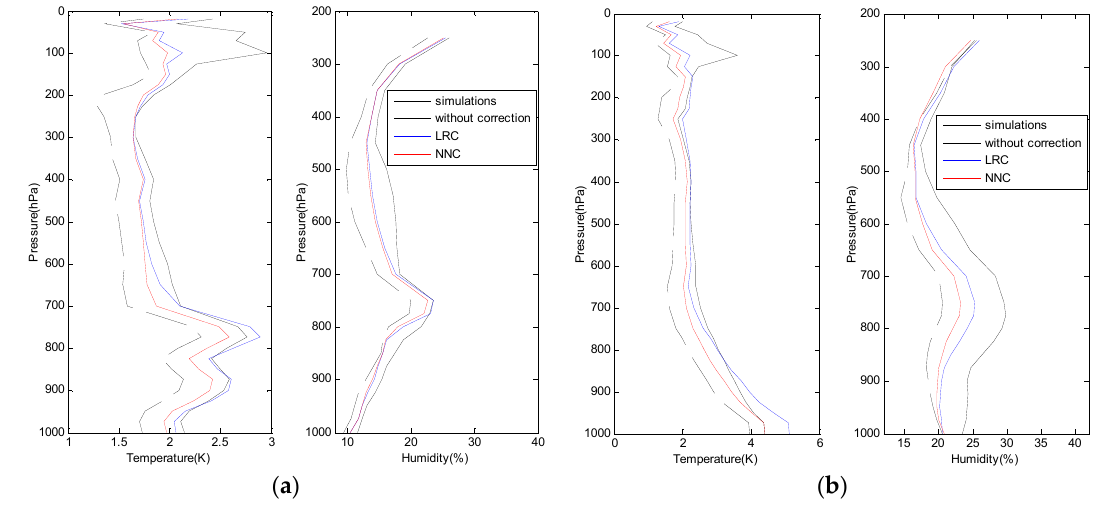
Figure 9. The retrieval RMSE with respect to NCEP Climate Forecast System (CFS) analysis over: ( a ) ocean; ( b ) land.